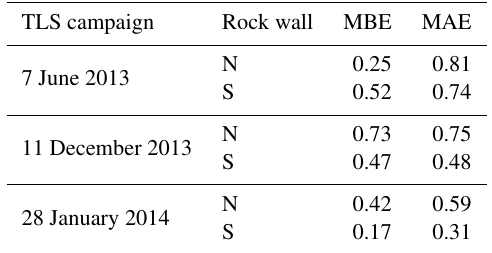
Table 2. Snow depth validation (MBE, MAE) between measured and modelled snow depths averaged over the entire N- and S-facing rock walls at the dates of the independent TLS campaigns. The MBE and MAE are in